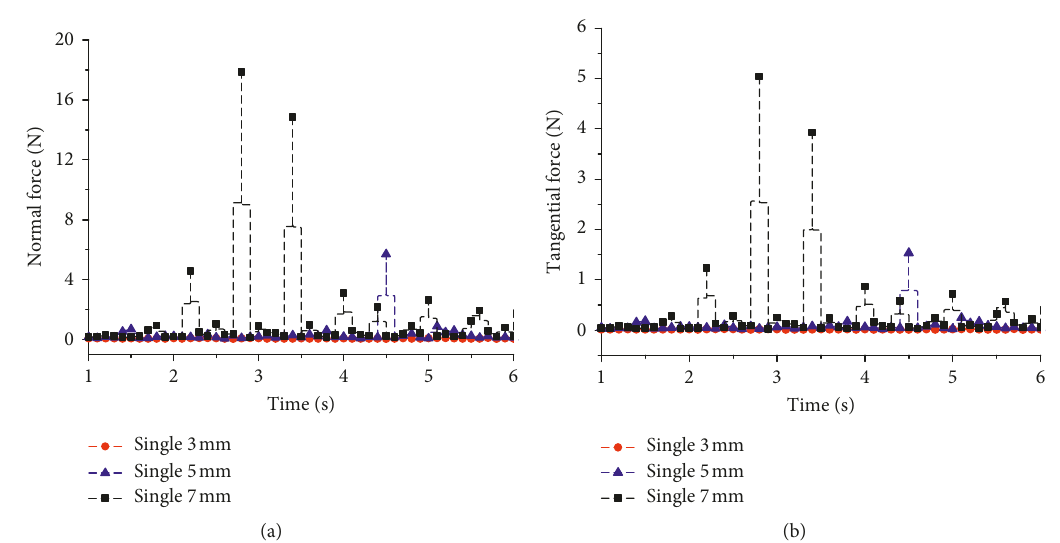
Figure 6: The contact force between particles with three different diameters in the single-flight screw